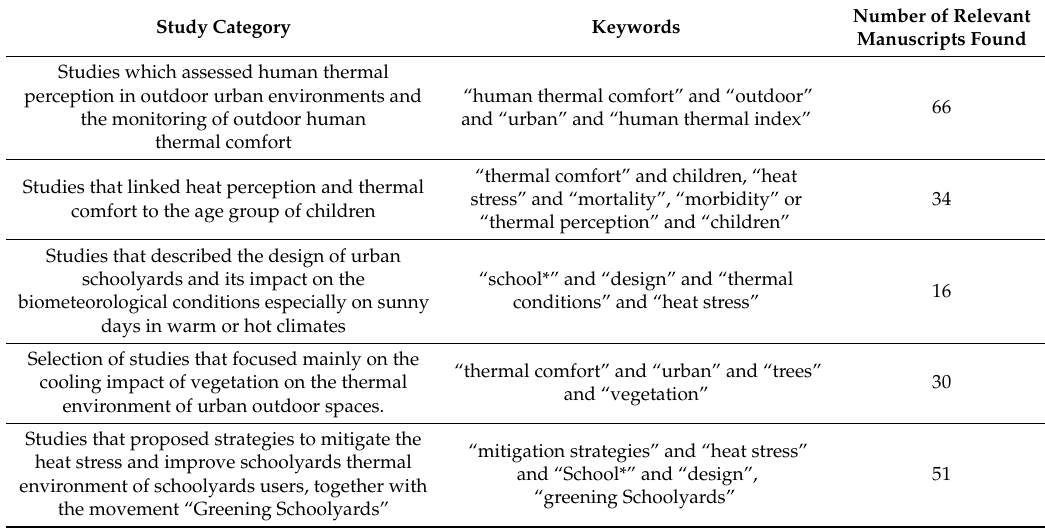
Table 1. Main categories and keywords of the literature studied and presented